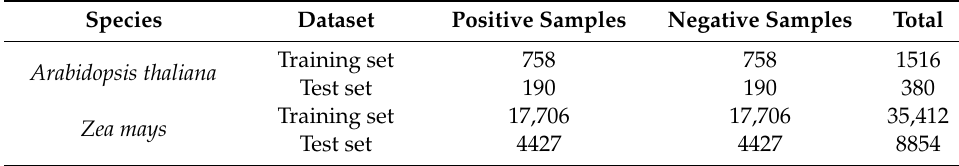
Table 1. Details of lncRNA–protein interaction datasets for two